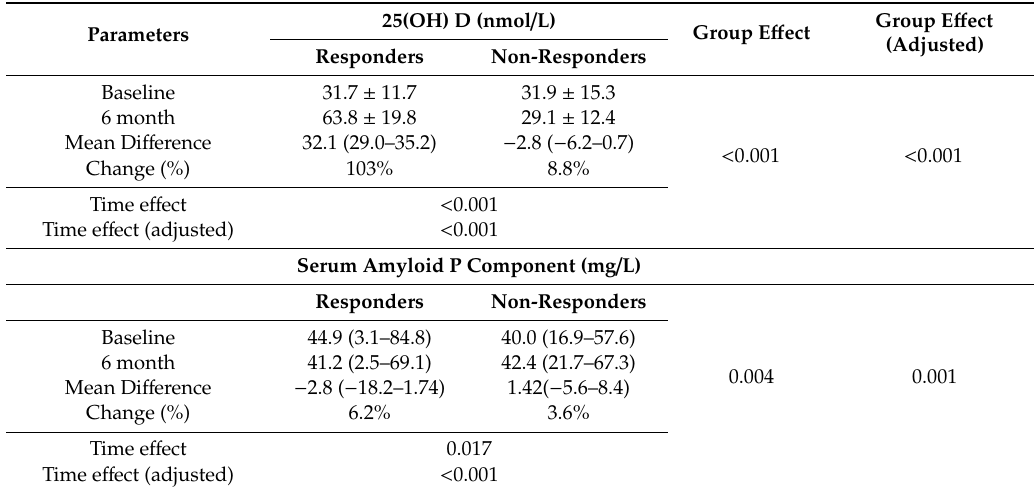
Table 2. Between-group comparisons in 25(OH)D and Serum Amyloid P